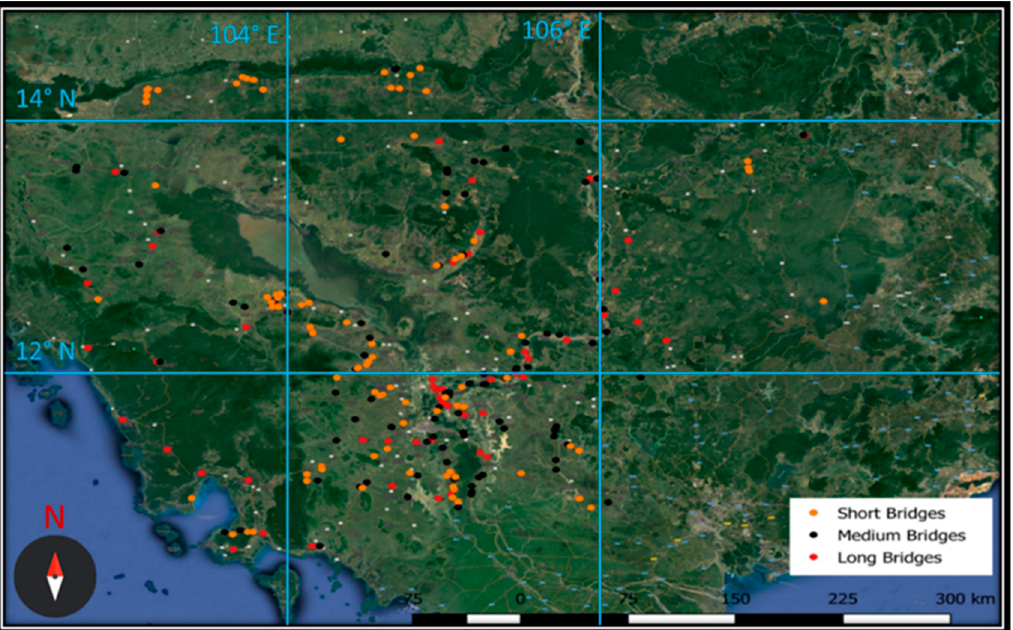
Figure 3. Location of the 261 bridges selected for this study in Cambodia (short, medium and long bridges combined).